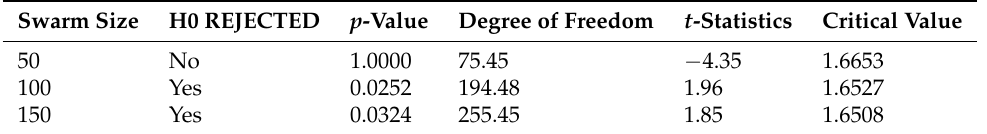
Table A1. One-tail two sample t